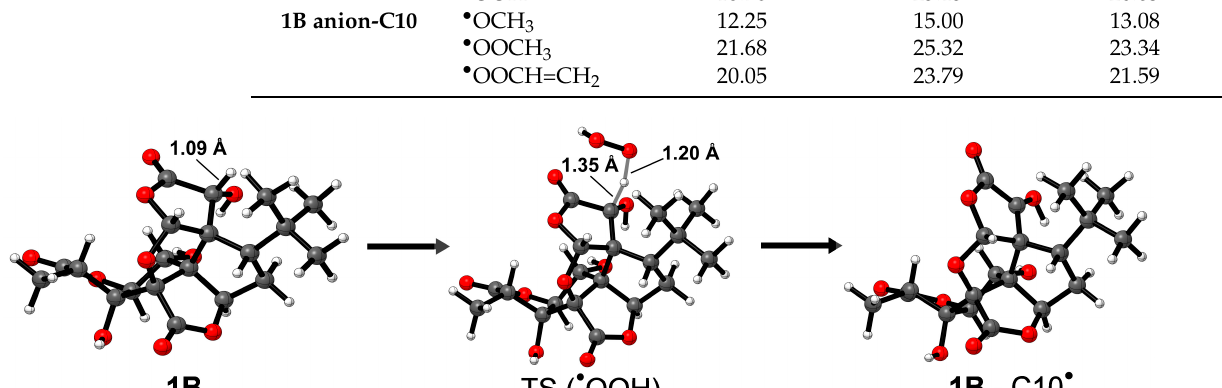
Figure 4. Fully optimized reactant, transition state and product (left to right) geometries of 1B when HAT occurs from C10 for the scavenging of • OOH. Relevant atomic distances are also reported in Å. Level of theory: M06-2X/6-31G(d).